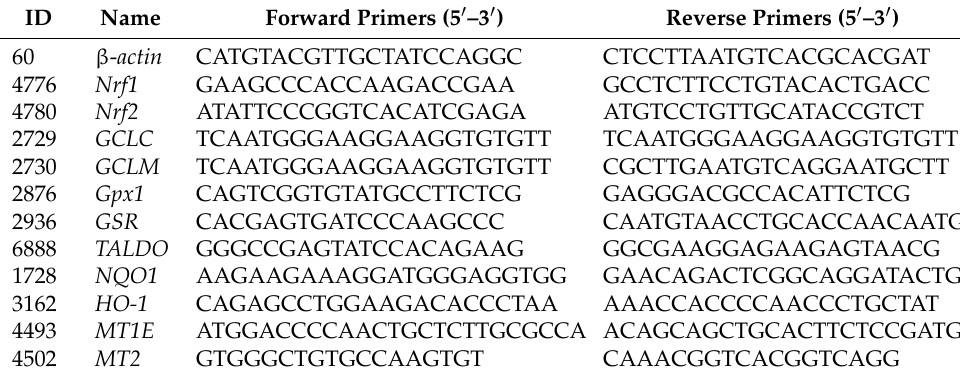
Table 1. Primer pairs used for the RT-qPCR